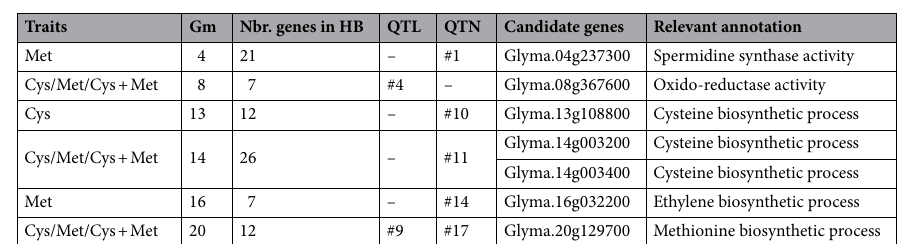
Table 3. Candidate genes underlying the reported QTLs/QTNs based on a relevant GO annotation.